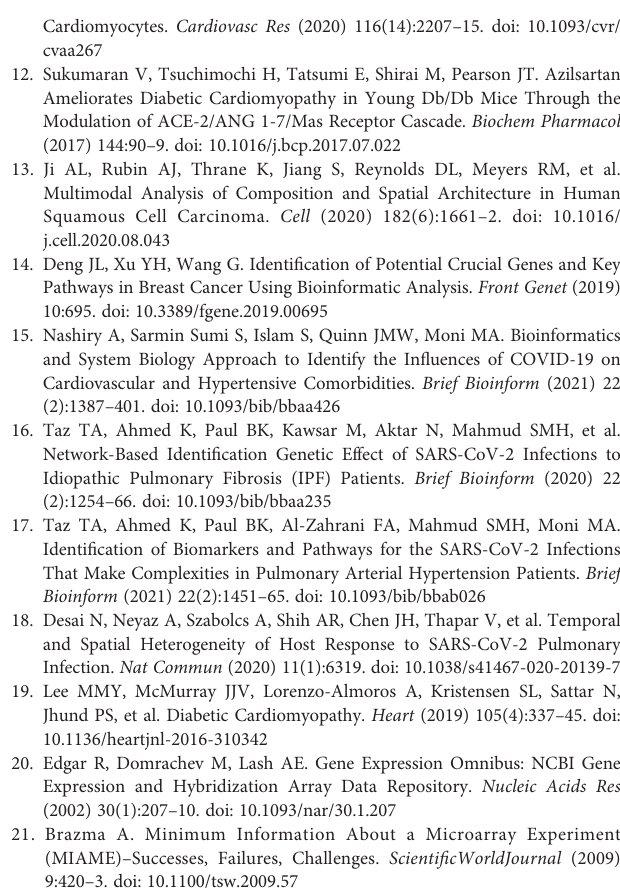
Supplementary Figure 1 | ∣ GO and KEGG enrichment analysis of overlapping DEGs. (A, B) Bubble maps showed the top-10 GO events associated with overlapping DEGs (green color). P < 0.05. The larger value of gene ratio represents the higher level of enrichment. The color of the dot stands for the different P -value, and the size of the dot re fl ects the number of target genes enriched in the corresponding event. (C) Volcano plots of sifted out DEGs for dataset GSE150316 vs GSE133054 (Human), and GSE161931 (Mice). (D) Ridge plots of KEGG analysis for DEGs. P < 0.05. Supplementary Figure 2 | ∣ Protein-protein interaction (PPI) network construction. (A,B) PPInetworkconstructedwiththeDEGsfromallthethreepublic datasets of GEO. (C) The signi fi cant module identi fi ed from the PPI network of overlapping homologous DEGs using the molecular complex detection (MCODE) method with a score of ≥